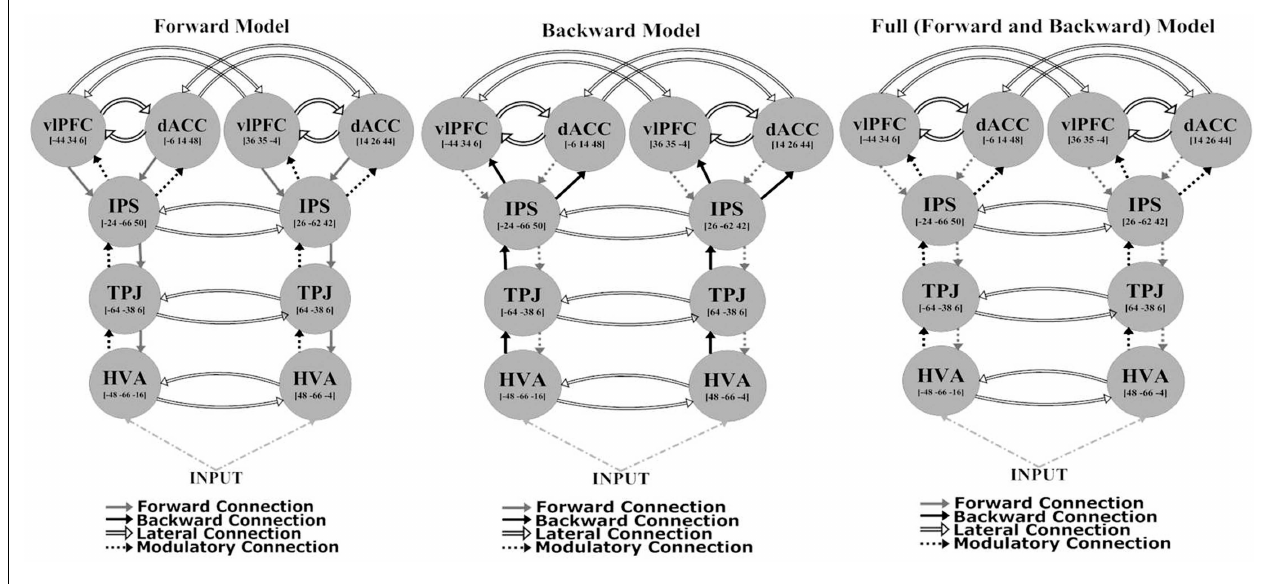
FIGURE 2 | Models used for the dynamic causal modeling analysis